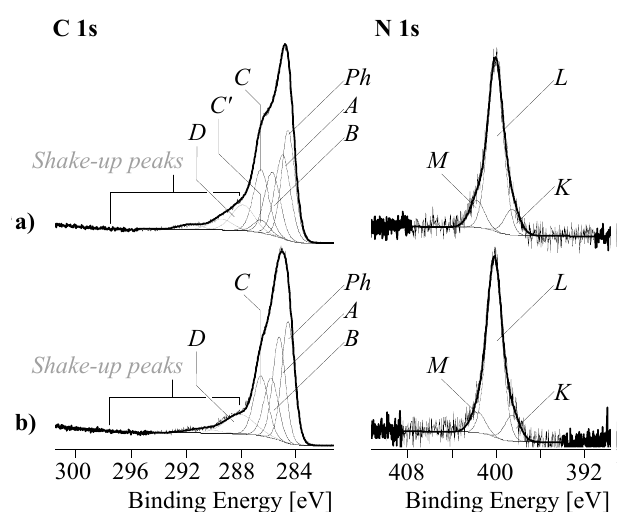
Figure 6. High-resolution C 1s (left) and N 1s (right) XPS spectra recorded from: ( a ) PDA-GO_90; and